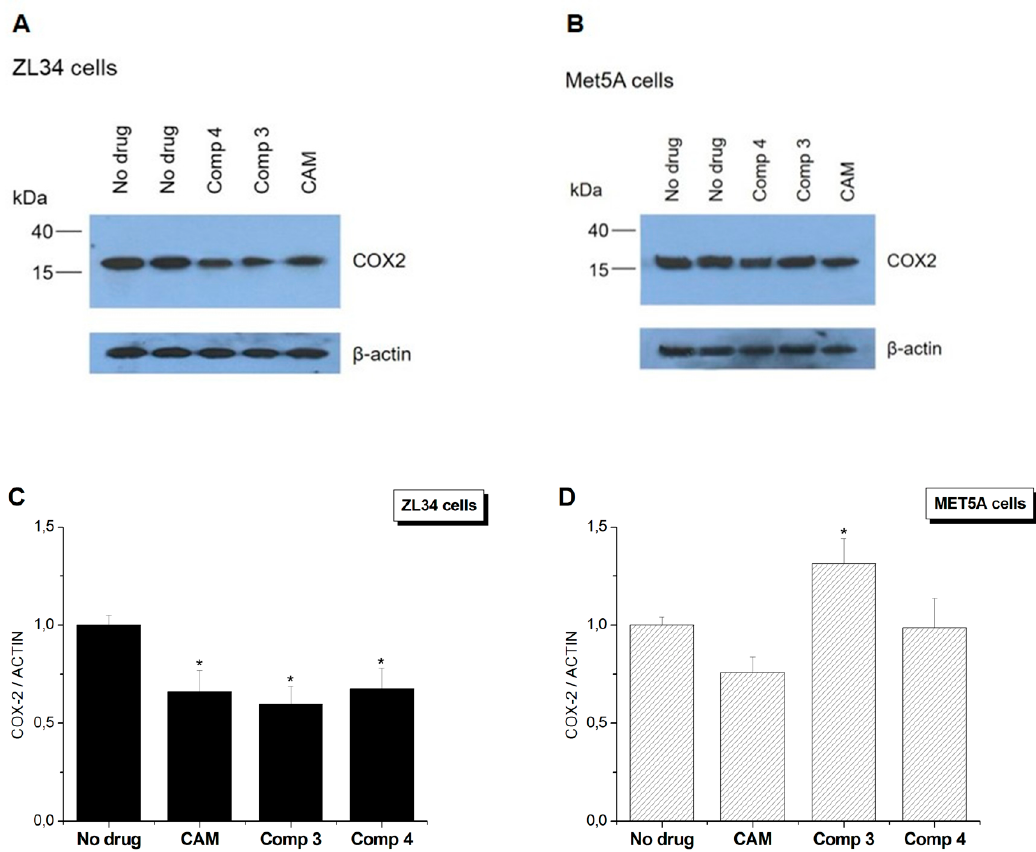
Figure 3. Effect of CAM or PA–CAM conjugates on cytoplasmic and mitochondrial protein synthesis. Western blot analysis on total protein extracts, derived from ( A ) ZL34 and ( B ) Met5A cells. ( C , D ) Quantification of COX2 protein levels compared to actin levels after normalization. * Significantly different values from those measured in control samples ( p <0.05).